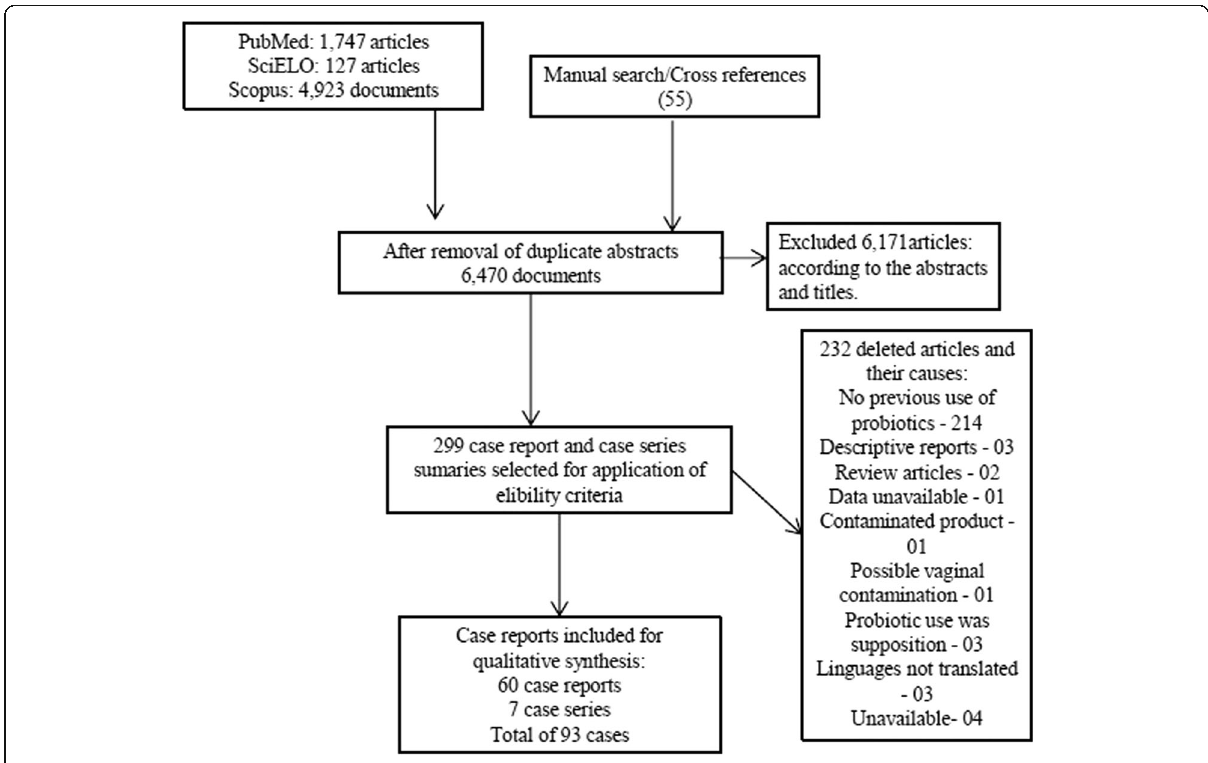
Fig. 1 Flow diagram of the article selection process at each stage of the systematic